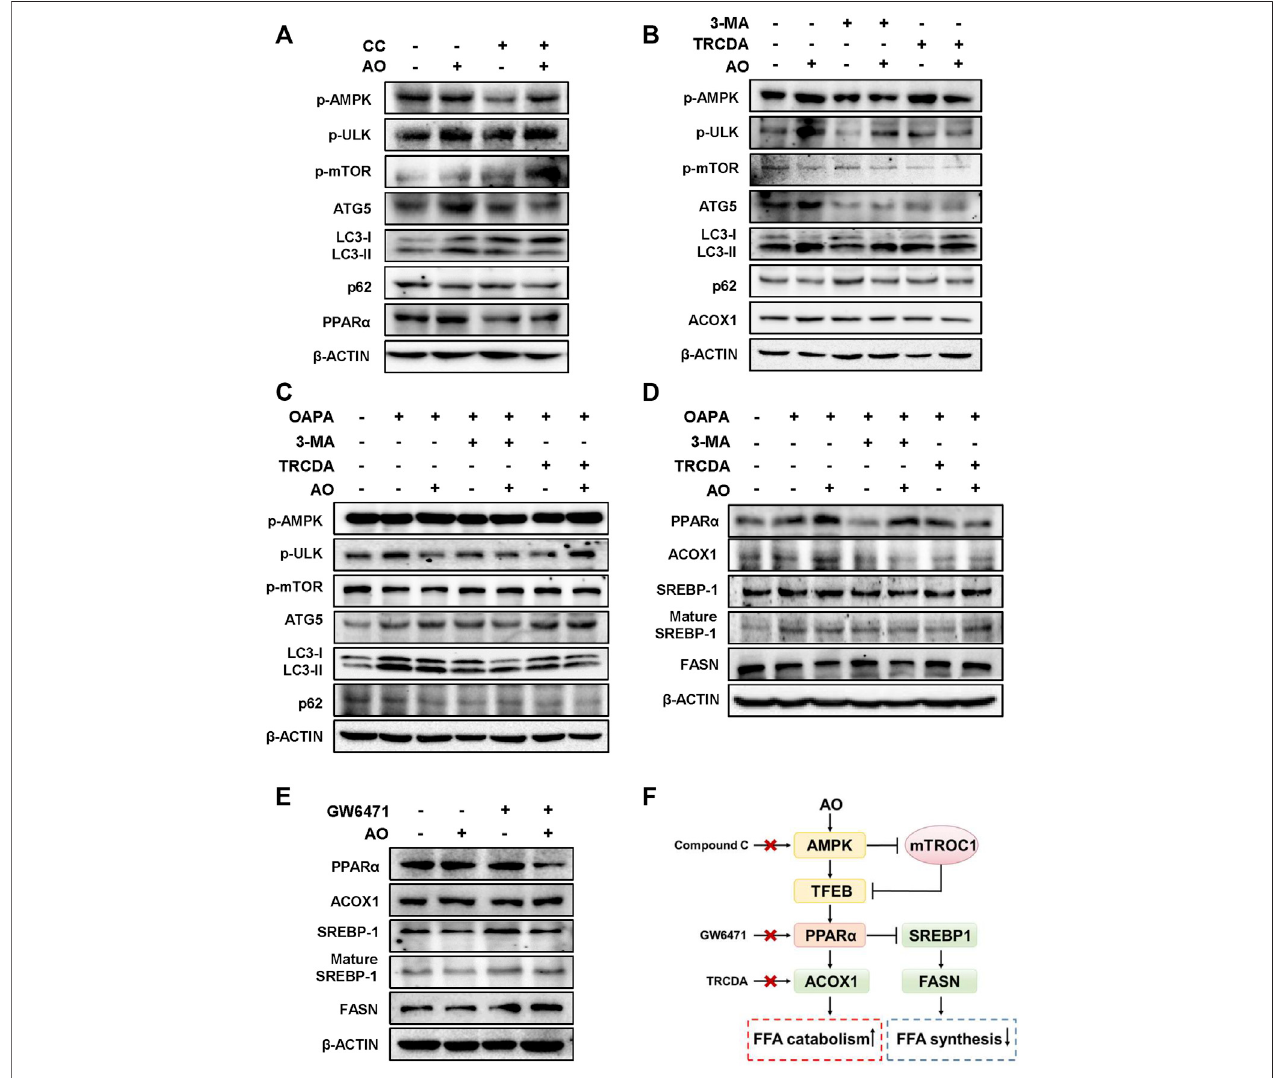
FIGURE 5 | AO alleviates lipid accumulation in hepatocytes by promoting AMPK-mediated protective autophagy (A) MPHs were pre-treated with CC (10 μ M) for 1.5 h and then administrated with AO (25 μ M) for another 2 h (B) After pretreatment with 3-MA (5 mM) or TRCDA (10 μ M) for 1.5 h, MPHs were administrated with AO (25 μ M) for another 2 h (C and D) After pretreatment with 3-MA (5 mM) or TRCDA (10 μ M) for 1.5 h, MPHs were administrated with AO (25 μ M) for another 24 h with or withoutOAPAtreatment (E) Afterpre-treatedwithGW6471(10 μ M)for1.5 h,MPHswereadministrated withAO(25 μ M)foranother2 h (A to E) Theproteinlevels ofp-AMPK,p-ULK,p-mTOR, ATG5,LC3-II/LC3-I,p62andPPAR α ,ACOX1,SREBP-1, matureSREBP-1andFASNinMPHsweredetermined bywesternblotusing β - ACTIN as a loading control (F) The pathway of AO in regulating FFA catabolism and